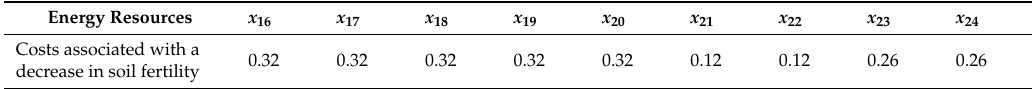
Table 7. Cost associated with a decrease in fertility (kWh /